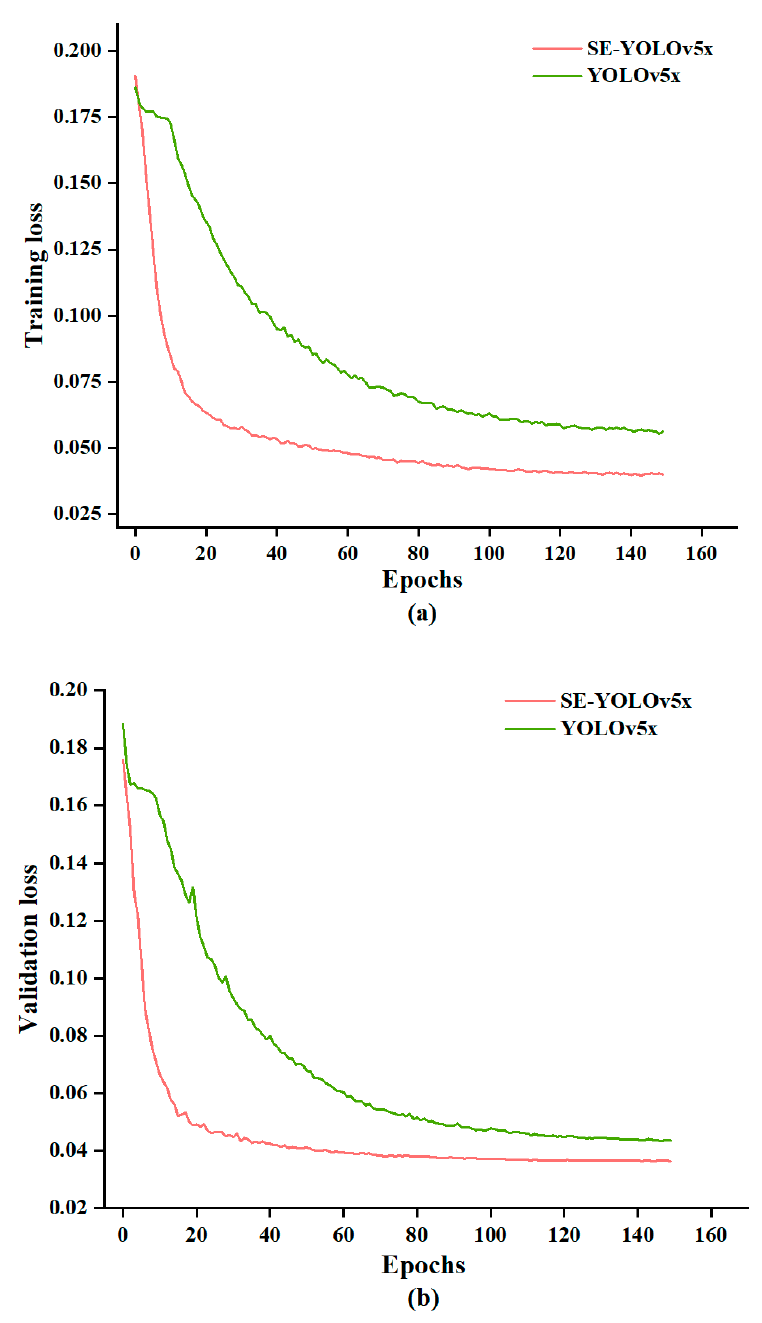
Figure 11. ( a ) The training loss curves and ( b ) the validation loss curves of SE-YOLOv5x and YOLOv5x.